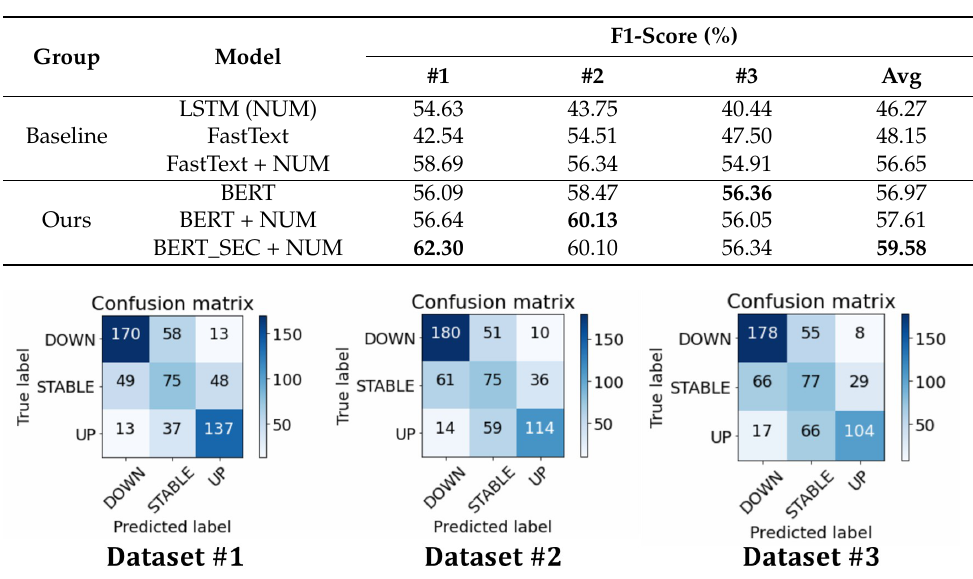
Table 9. Model comparison in terms of “F1-score” on testing data based on a 3 fold-cross validation (#1, #2, #3 refers to the result of each fold), and the boldface is the winner.